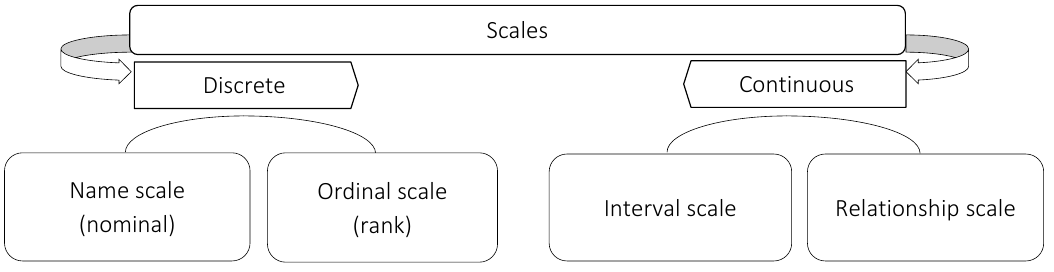
Table 7. Interpretation limits of the results of assessing a country’s financial security using the multiplicative non-linear convolution model